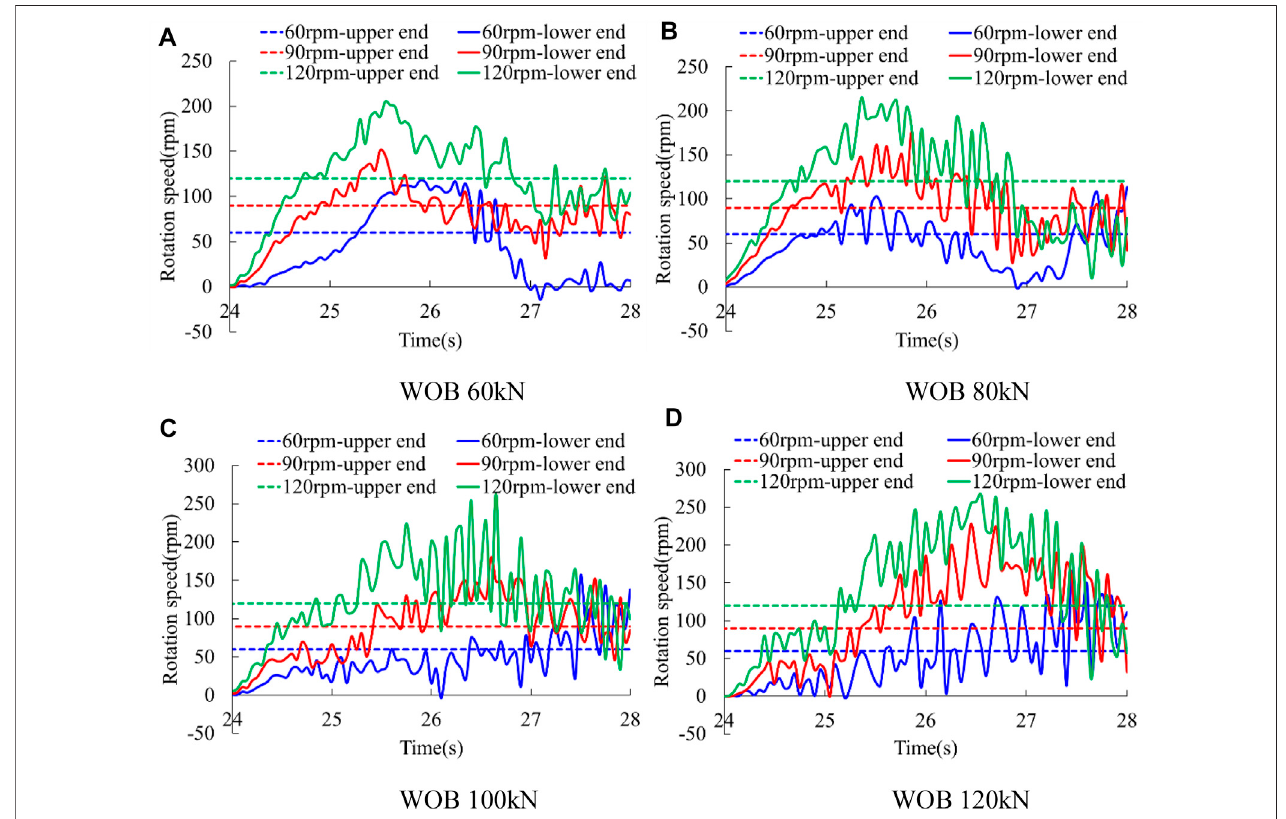
FIGURE 6 | Rotation speed at the upper end and lower end of drill string in drilling process. (A) WOB 60 kN (B) WOB 80 kN (C) WOB 100 kN (D) WOB 120 kN.